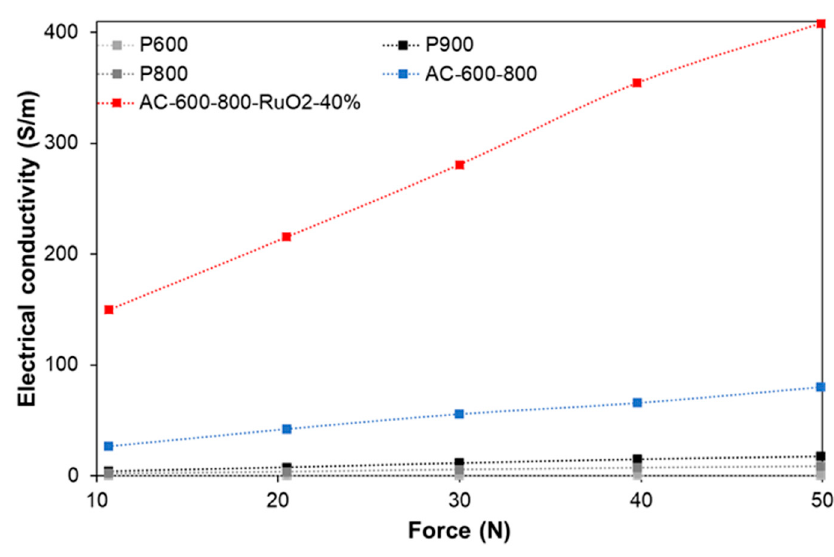
Figure 9. Electrical conductivity in S m − 1 vs. pressure in N for pyrochars (P600, P800, P900), AC-600- 800 and the composite AC-600-800-RuO2-40.